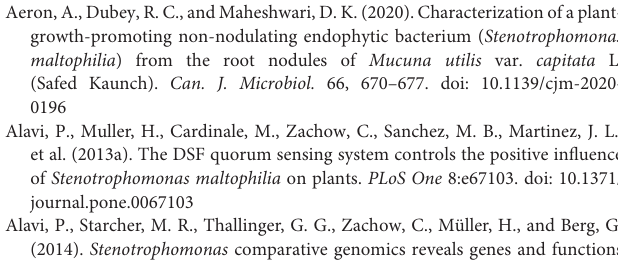
Supplementary Table 1 | List of genetic features identified in the genome of Stenotrophomonas sp. 169, which are potentially involved in colonization, plant development and stress